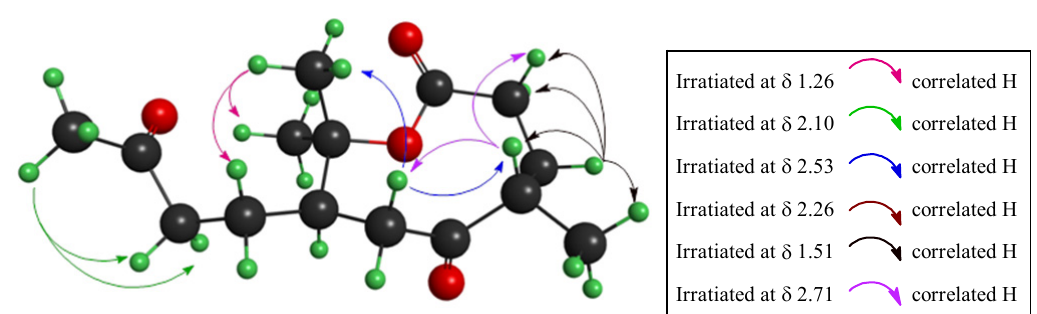
Table 3. NMR Spectroscopic Data for Compound 3 (DMSO- d